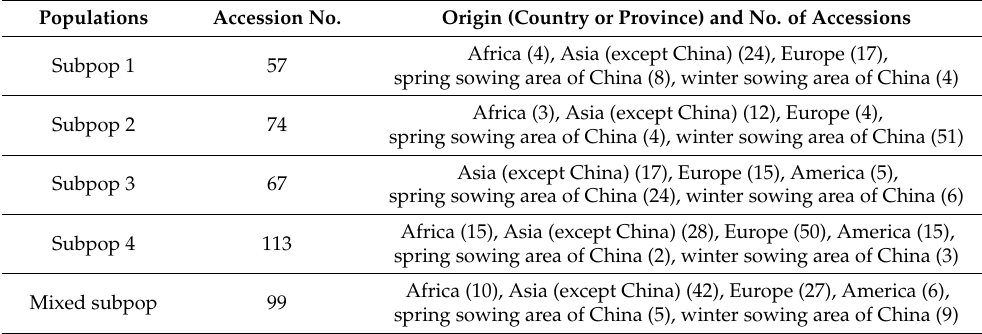
Table 2. The compositions of subpopulation calculated by population structure analysis of 410 faba bean accessions based on 38,111 SNP markers (Q ≥ 0.5).